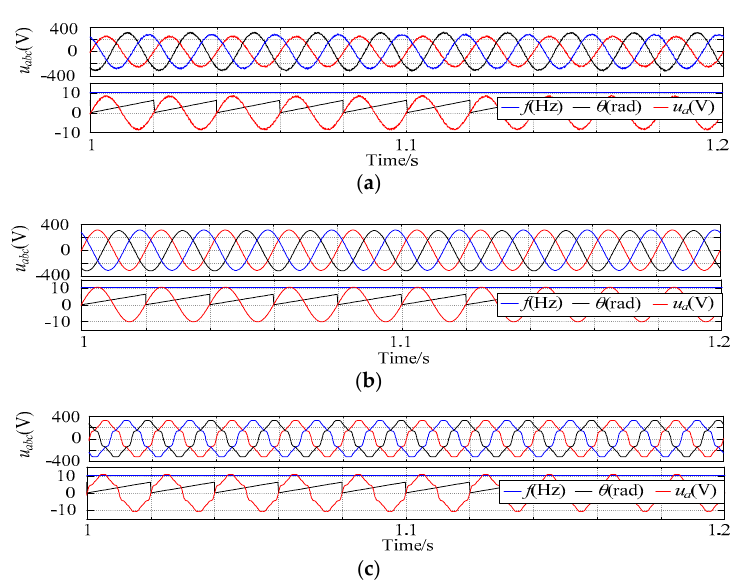
Figure 6. Dynamic performance waveform based on CGI-PLL in complex voltage conditions: ( a ) Dynamic performance waveform based on CGI-PLL in unbalanced voltage with high frequency components condition; ( b ) Dynamic performance waveform based on CGI-PLL in voltage with DC component condition; ( c ) Dynamic performance waveform based on CGI-PLL in voltage with 5th and 7th harmonic components condition.